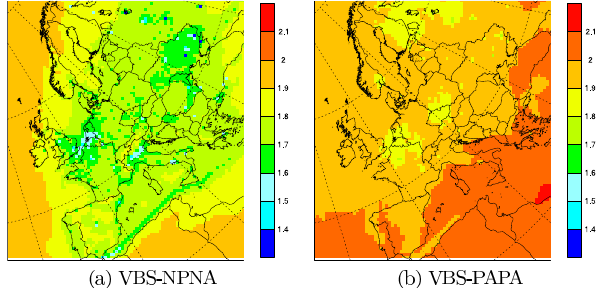
Fig. 6. Model calculated OM/OC ratio in PM 2 . 5 with two of the model versions, NPNA giving the lowest ratios and PAPA giving the highest. Average OM/OC for the whole 6-yr period